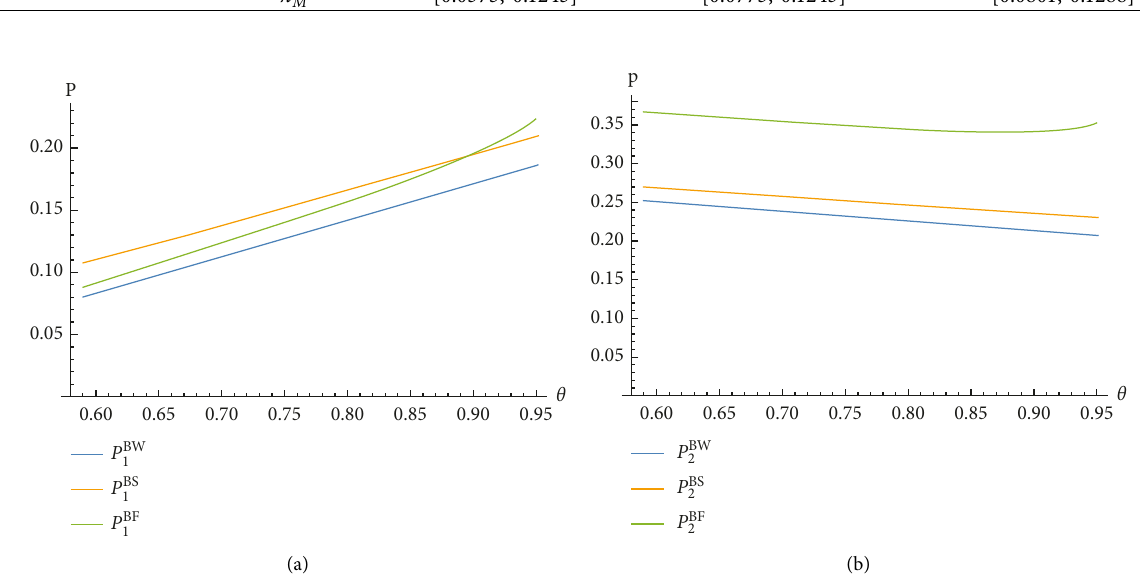
Figure 2: Price comparison with respect to θ . (a) θ vs. p